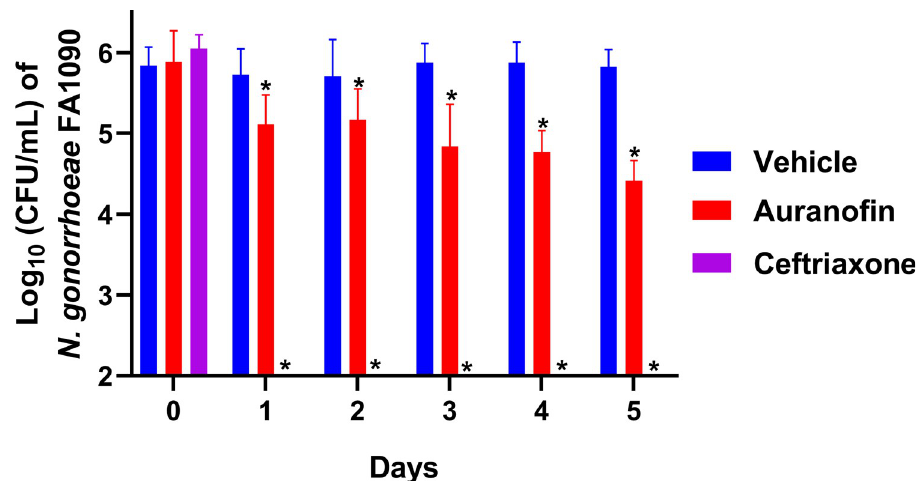
Fig 2. Viable count of Neisseria gonorrhoeae (average ± standard deviation log 10 CFU/mL) recovered from vaginal swab of mice over the course of five days of treatment with vehicle, auranofin, or ceftriaxone. Female ovariectomized BALB/c mice that were subcutaneously implanted with 5-mg, 21-day controlled-release estradiol pellets were infected intravaginally with N . gonorrhoeae FA1090 and then were treated orally with auranofin (0.25 mg/ kg) or vehicle (10% DMSO:10% Tween 80:80% PBS) for five consecutive days. As a positive control, a group of mice received a single intraperitoneal dose of ceftriaxone (15 mg/kg). Vaginal swabs were collected daily and cultured to determine the number of viable bacteria colonizing the vagina of mice. The data were analyzed via a two-way ANOVA with post-hoc Dunnett’s test for multiple comparisons. An asterisk ( � ) indicates a significant difference ( P < 0.05) between mice treated with auranofin or ceftriaxone compared with the